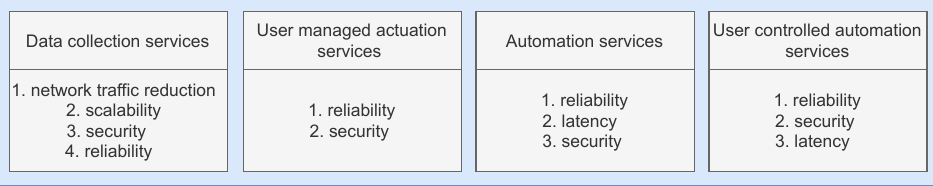
Figure 1. Prioritization of QoS parameters in different IoT service